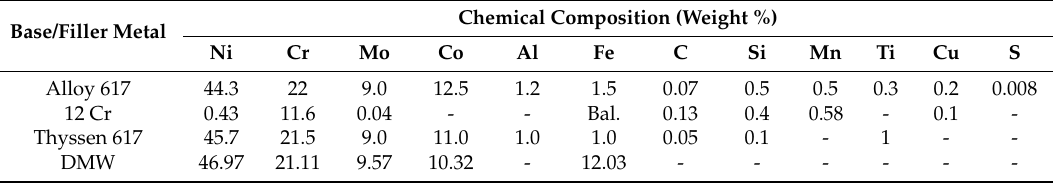
Table 1. Composition analysis of base metals, filler metal, and dissimilar material weld (DMW).